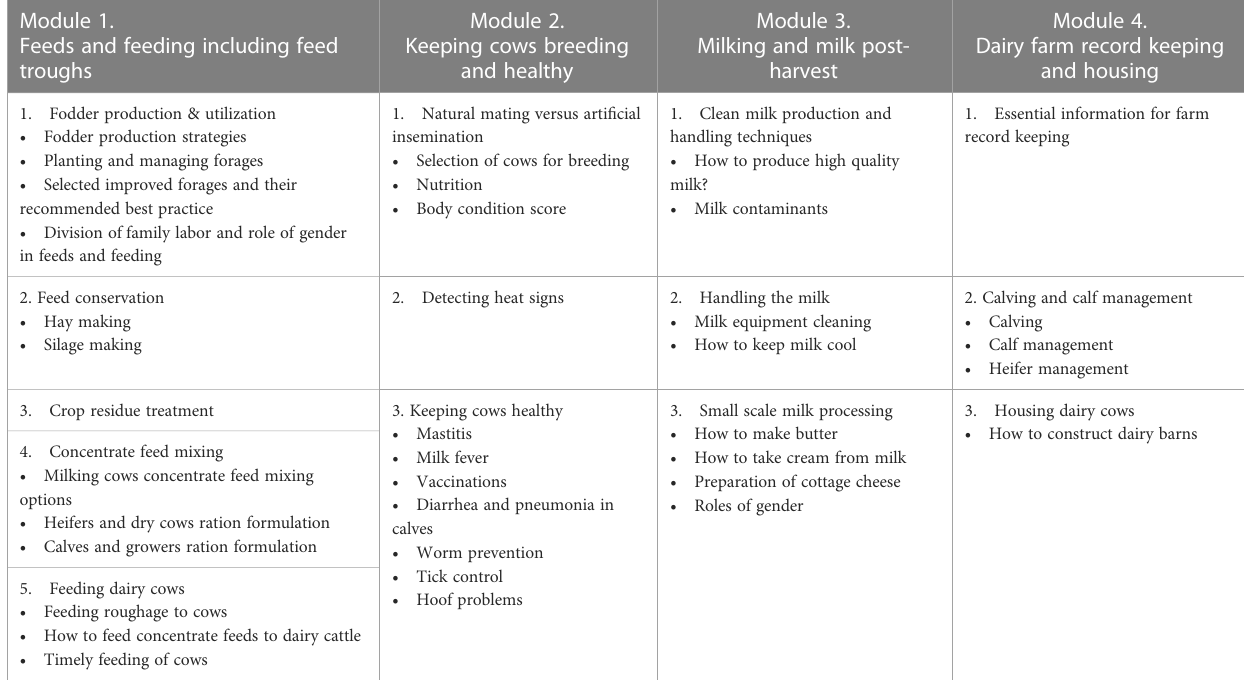
TABLE 2 Training modules used for the training of trainers (ToT) and smallholder dairy farmers. Module 1. Feeds and feeding including feed